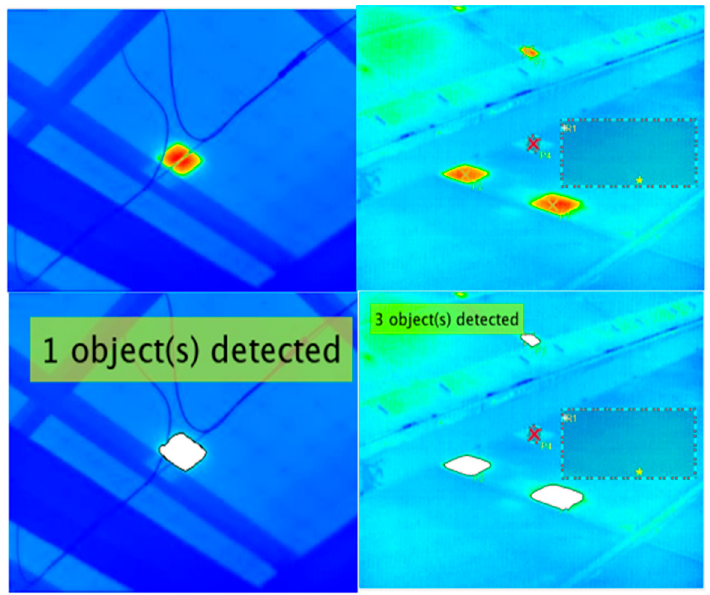
Figure 3. The images taken by an hand-held IR imager that were used to validate if the algorithm image processing with edge detection can count the number of hotspots of image processing with edge detection can count the number of hotspots accurately.